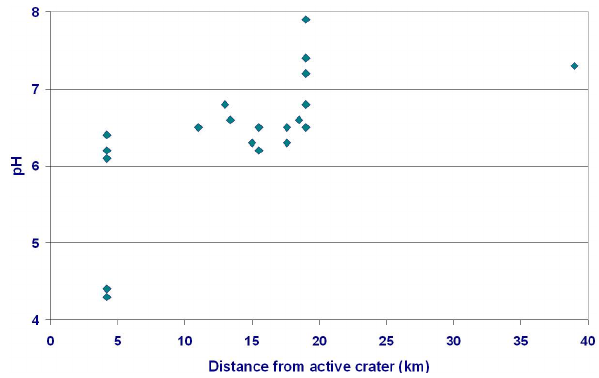
Table 2. Dietary tolerance to fluoride.